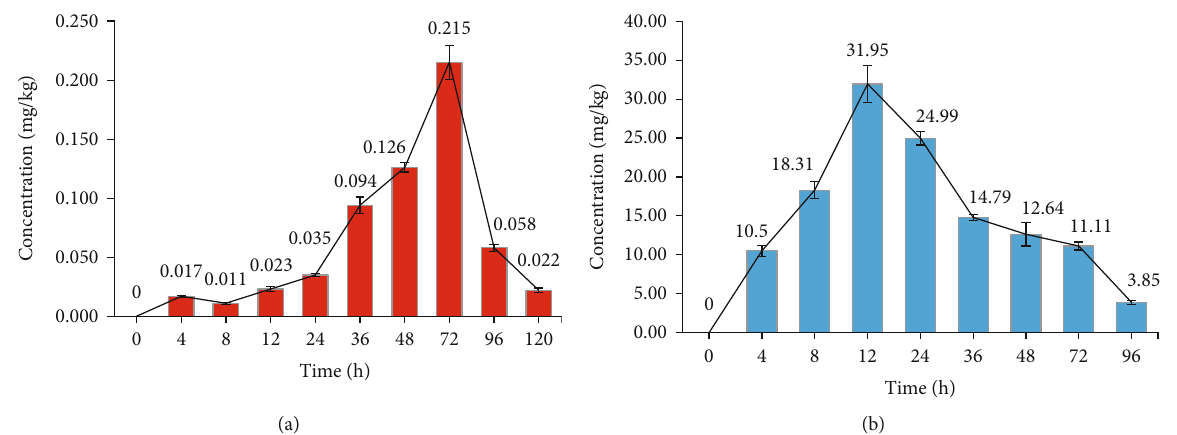
Figure 3: Systemic inhalation of vanisulfane in tobacco, conducts downward (a) and upward